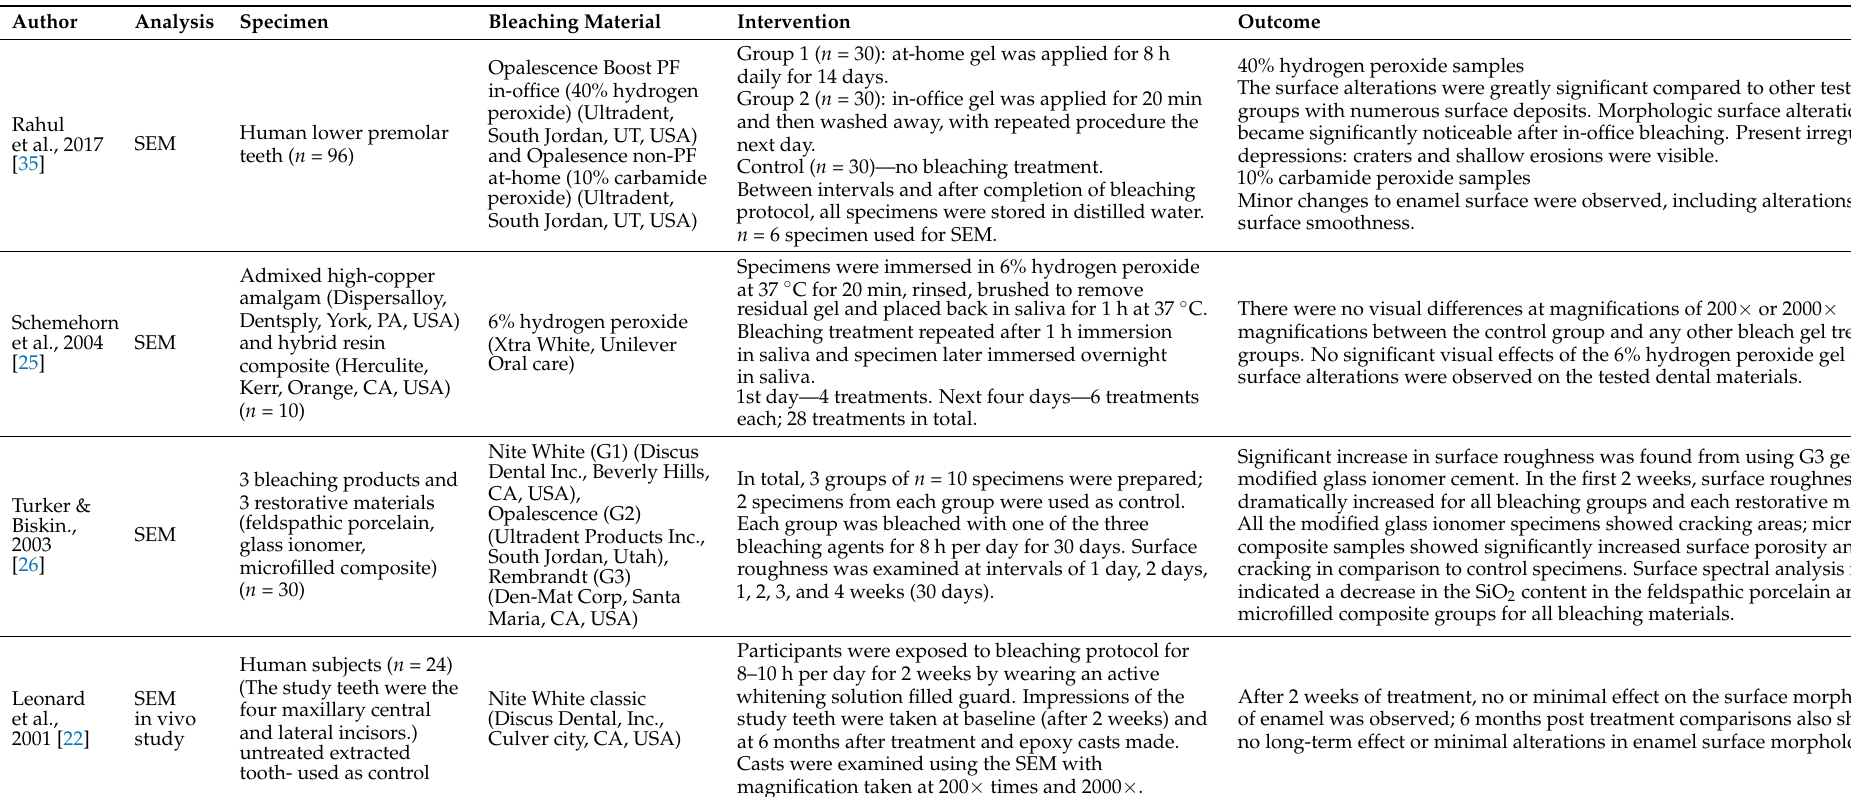
Table 4. Main findings of studies on surface roughness of enamel after